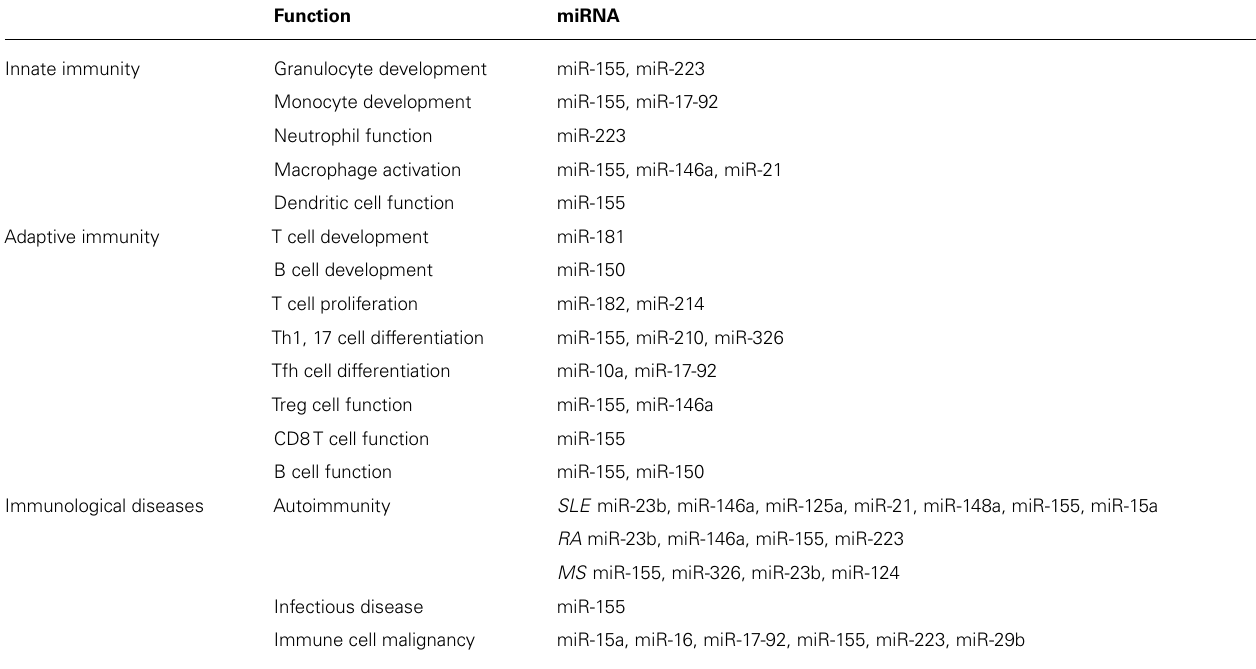
Table 1 | miRNAs involved in immune